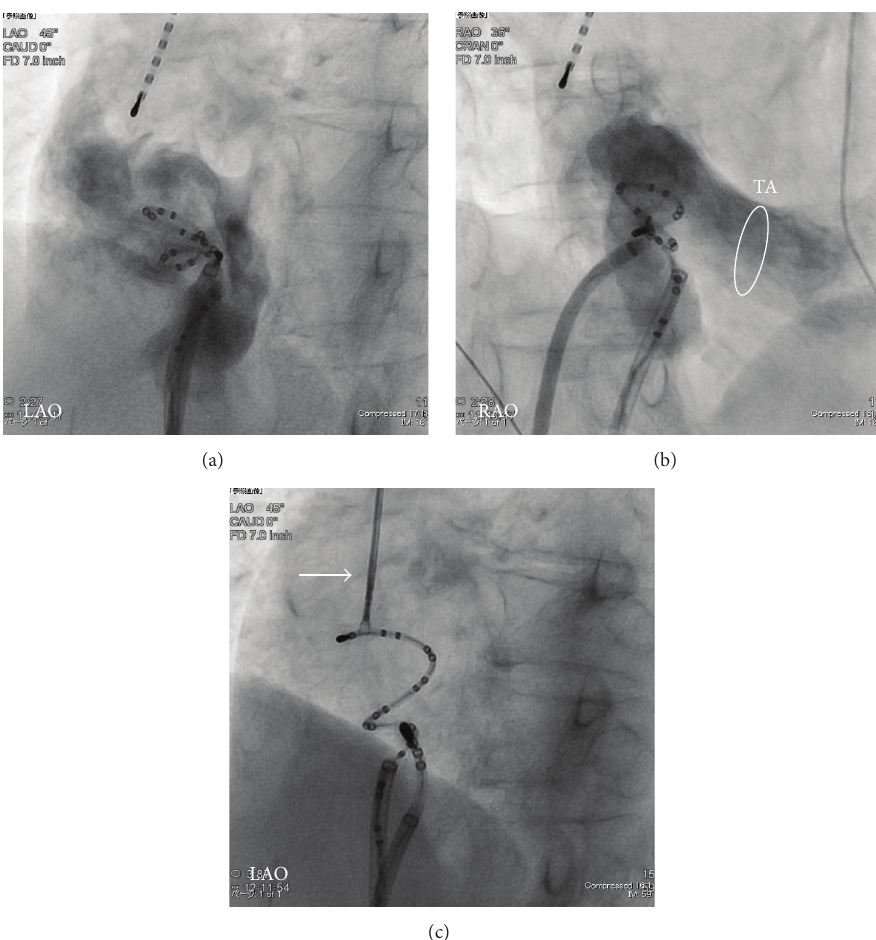
Figure 2: The images of fluoroscopy. Right atriography revealed the entrapped catheter was distant from tricuspid valve, posterior wall of right atrium (RA) in left anterior oblique (LAO) view (a), and lateral wall of RA in right anterior oblique (RAO) view (b). The head of multiloop mapping catheter was apart from tricuspid annulus (TA). The forceps (arrow) designed for endomyocardial biopsy caught the head of multiloop mapping catheter and twined connective tissues